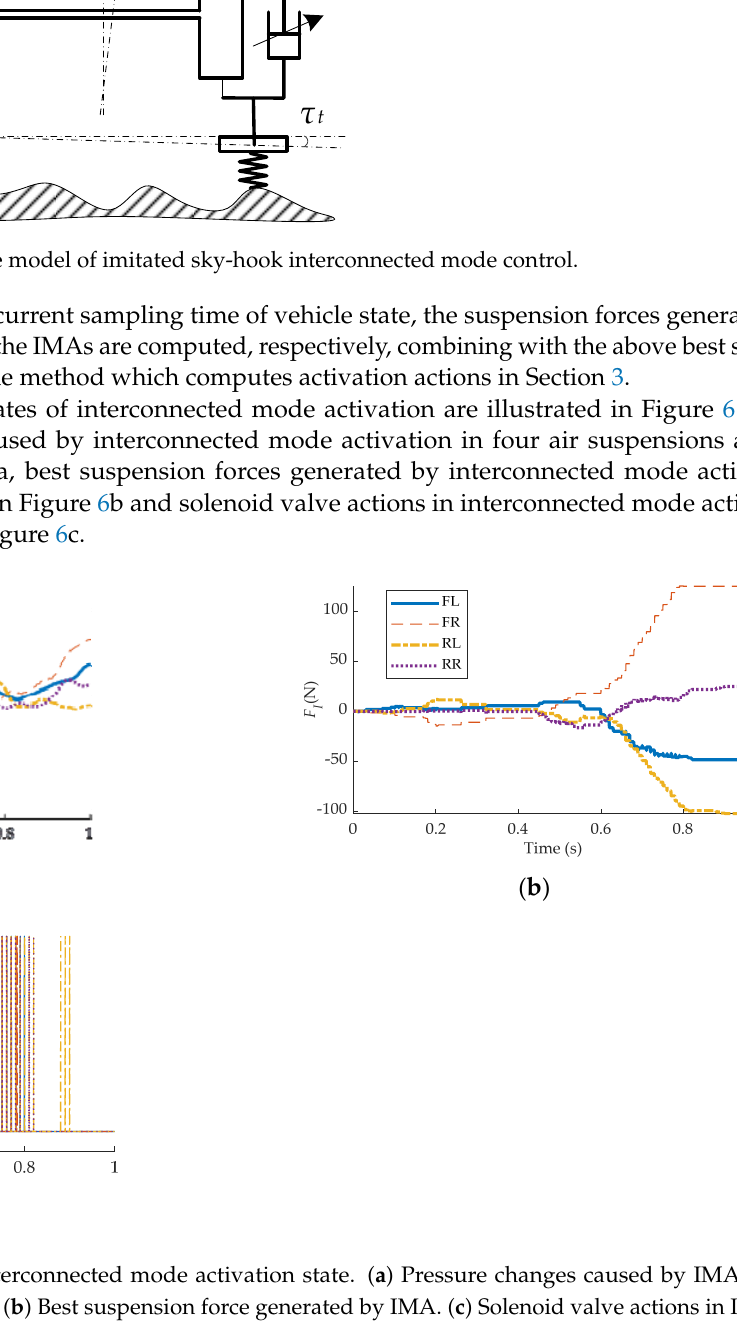
Figure 6. Interconnected mode activation state. ( a ) Pressure changes caused by IMA in four air suspensions. ( b ) Best suspension force generated by IMA. ( c ) Solenoid valve actions in IMA.